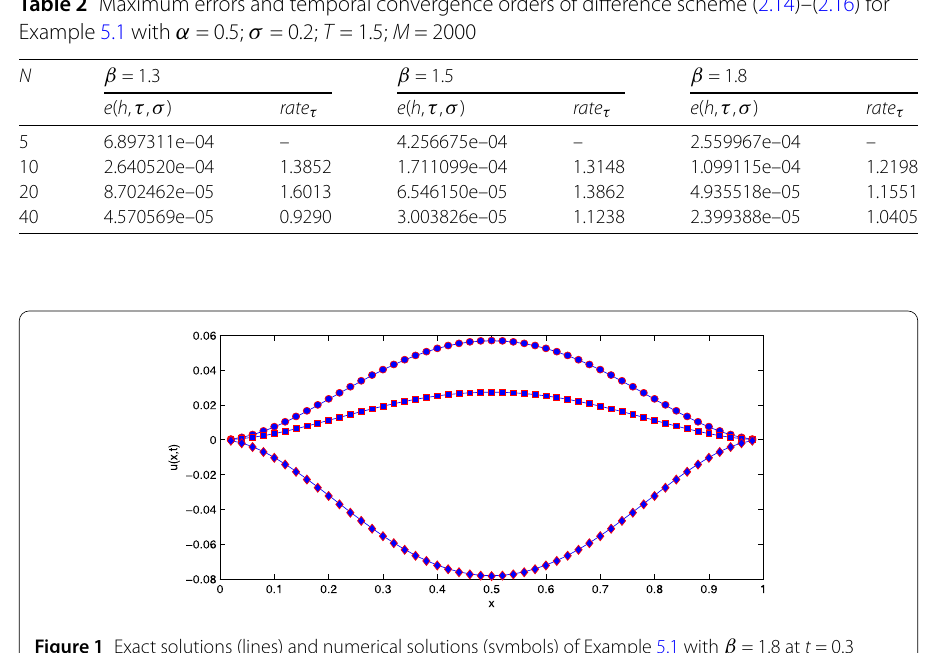
In Figs. 2 and 3, the eigenvalue plots of the original matrix M k +1 and the